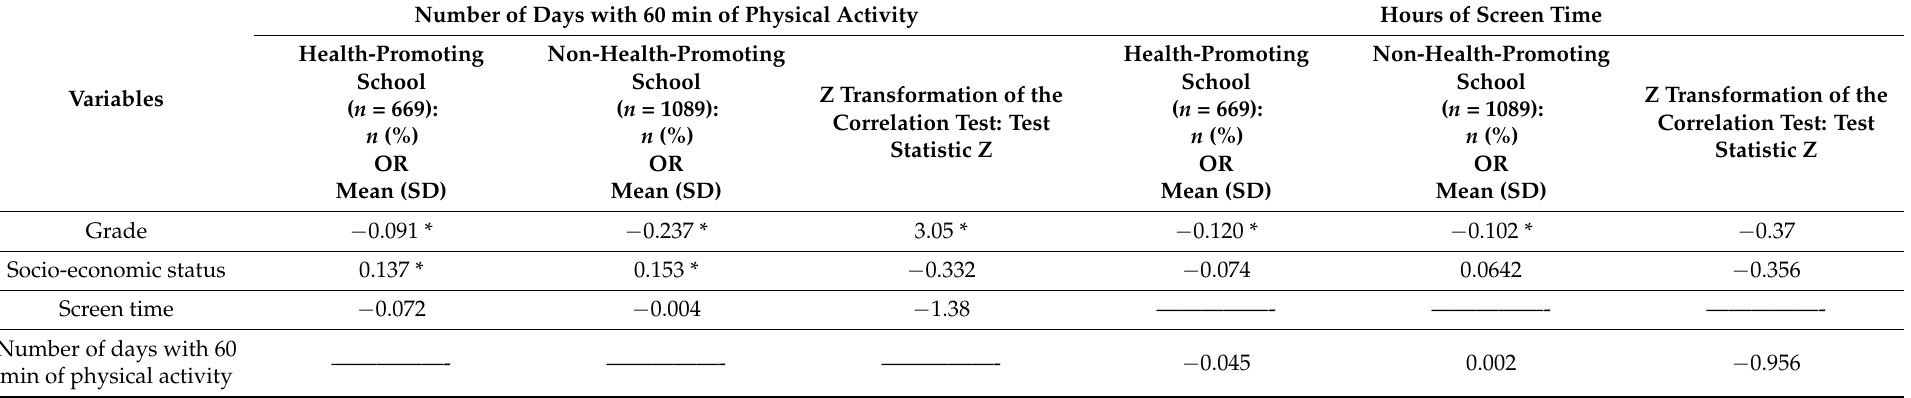
Table 3. Continuous and ordinal variable associations with number of days/week with 60 min of physical activity and hours of screen time.